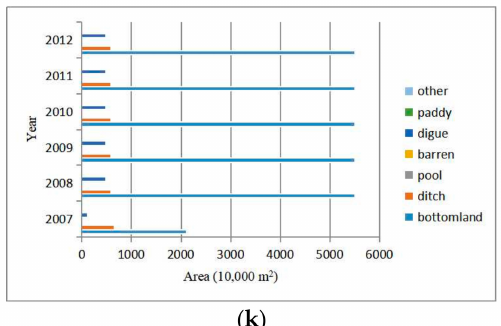
Figure 3. Coverage areas of O. hupensis in di ff erent land use types. ( a ) Tianmen City; ( b ) Jiangling County; ( c ) Qianjiang City; ( d ) Xiantao City; ( e ) Shashi District; ( f ) Songzi City; ( g ) Gong’an County; ( h ) Honghu City; ( i ) Jingzhou District; ( j ) Shishou City; ( k ) Jianli County.